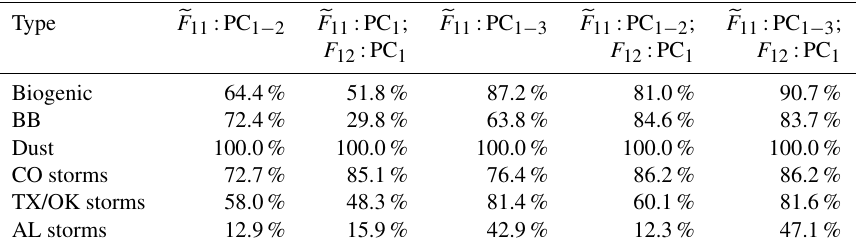
Table 2. Recall for the clustering based on Mahalanobis distance for each aerosol type, given different combinations of principal component scores. The PCA combinations that the prediction technique was applied to include the first two e F 11 scores ( e F 11 :PC 1 − 2 ), the first e F 11 and − F 12 /F 11 scores ( e F 11 :PC 1 ; F 12 :PC 1 ), the first three e F 11 scores ( e F 11 :PC 1 − 3 ), the first two e F 11 scores and first − F 12 /F 11 scores